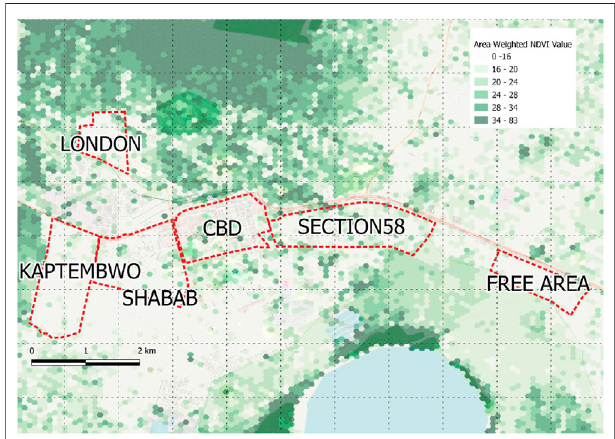
FIGURE 7 | Nakuru Mean NDVI Jan-Dec 2018 (Landsat Imagery) [ source: http://climateengine.org/]. Values have been visualized as mean area weighted NDVI values by 100 m hex grid derived from original 29 m pixels.